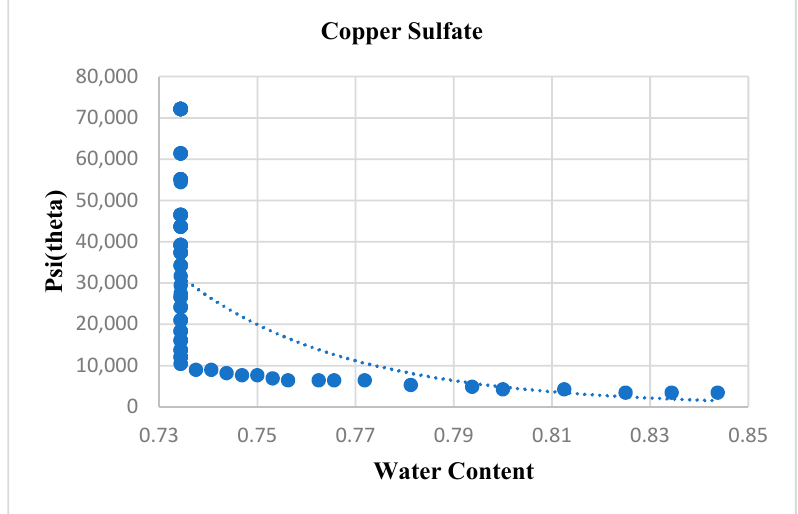
Figure 4. Decay model for copper chloride .